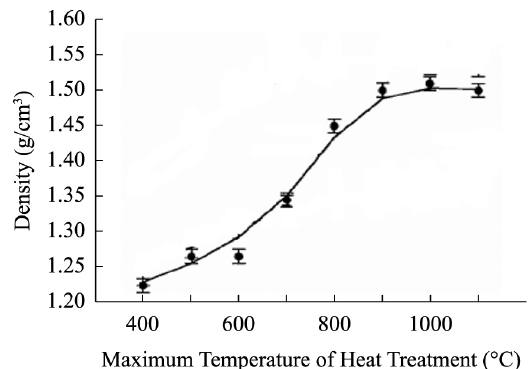
Figure 2. Density change during pyrolysis of thermoset phenolic resin up to 1000°C [ 31 ] .